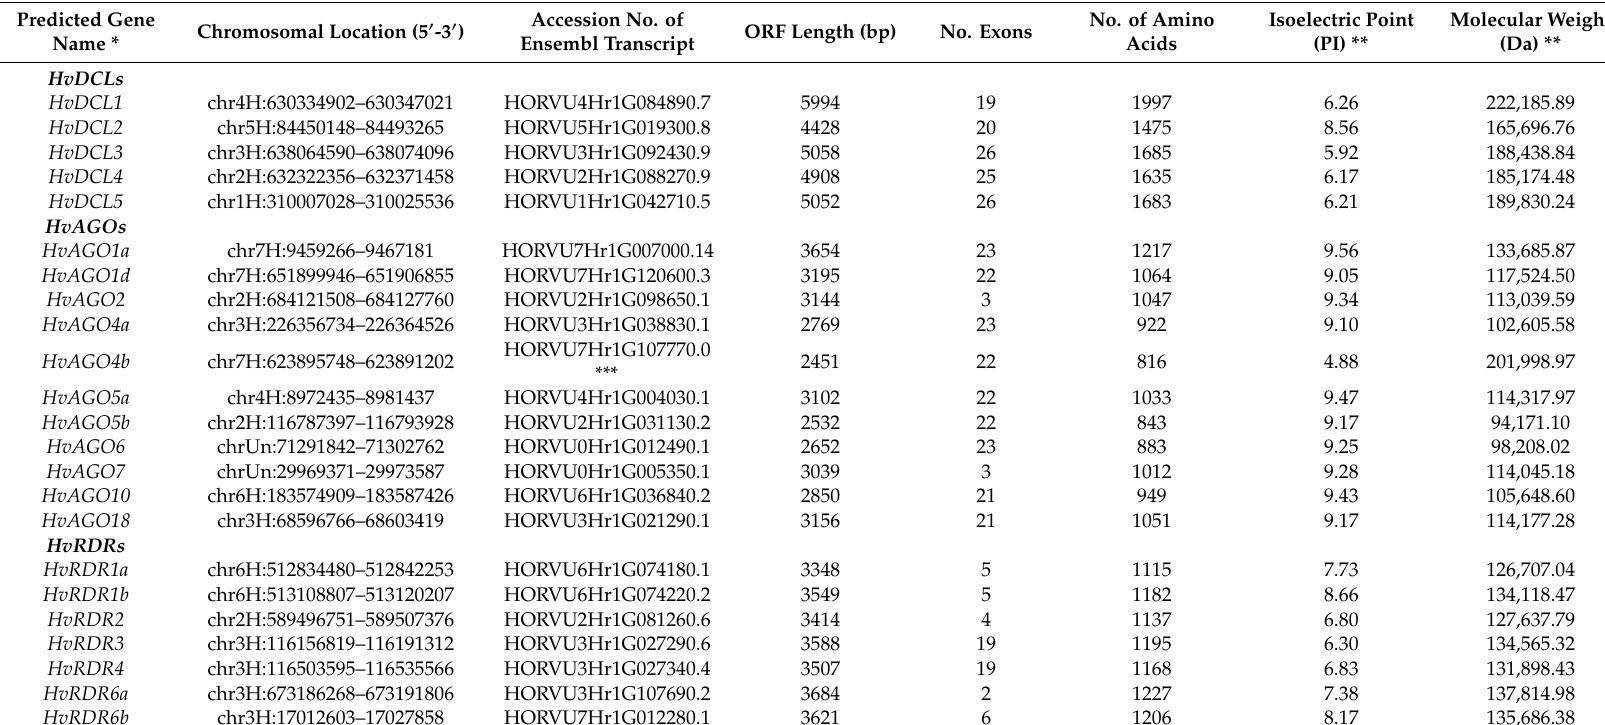
Table 1. Features of predicted H. vulgare DCL, AGO and RDR